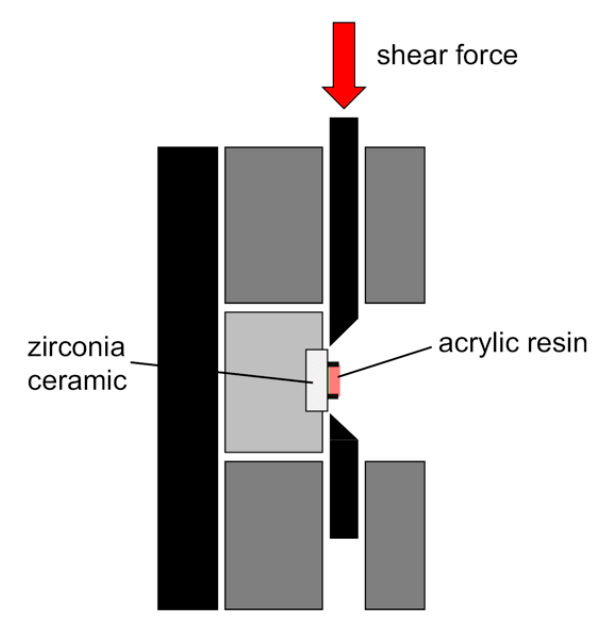
Figure 2. Schematic diagram of shear bond strength (SBS) testing and testing jig.